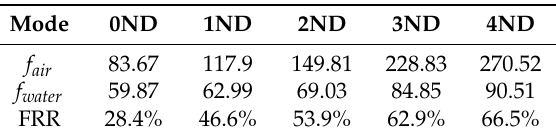
Table 4. Natural frequencies in air, water and frequency reduction ratios (FRR). No cavitation condition and machine working close to BEP.